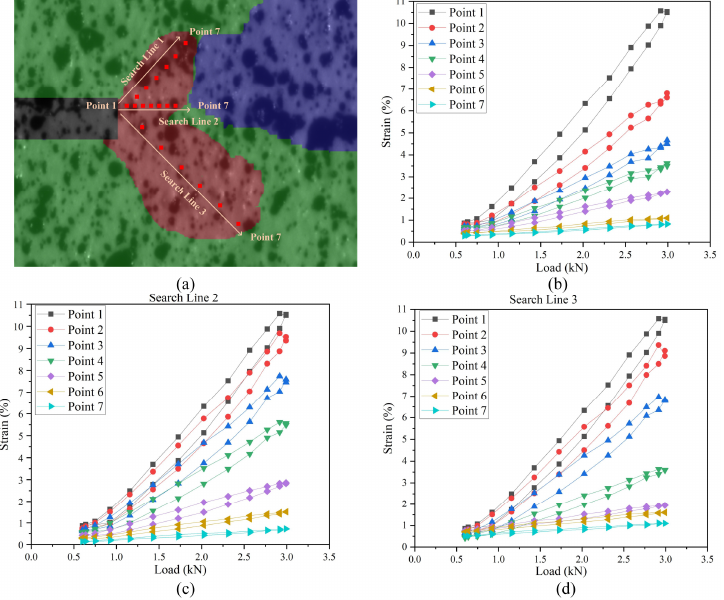
Figure 22. Load–strain curves at the different positions in the CPZ: ( a ) Arrangement of measuring points; ( b ) load–strain curves of search line 1; ( c ) load–strain curves of search line 2; ( d ) load–strain curves of search line 3.